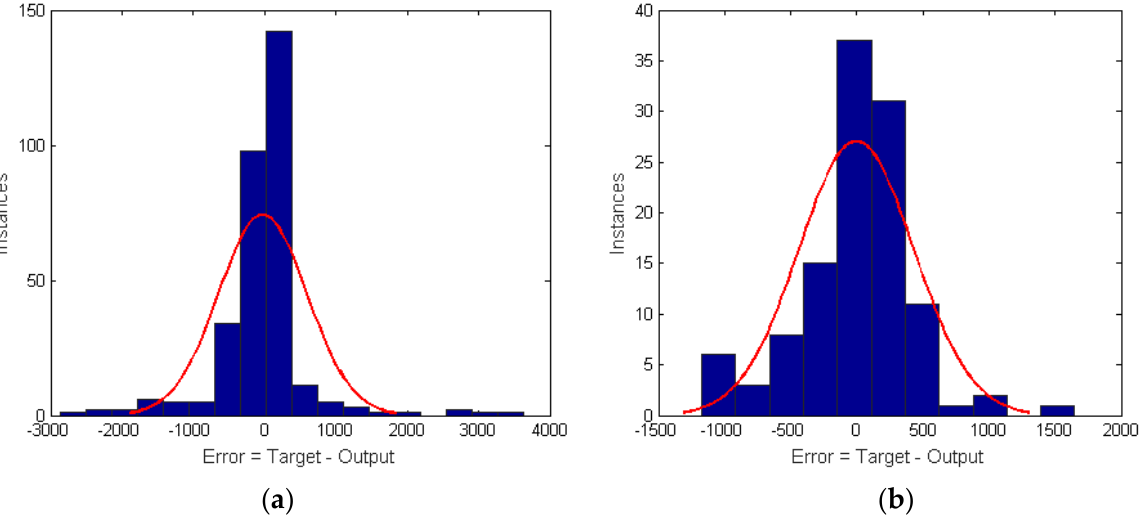
Figure 10. ( a ) Household No 73—Working days forecast error distribution; ( b ) household No 73—Weekend forecast error distribution.